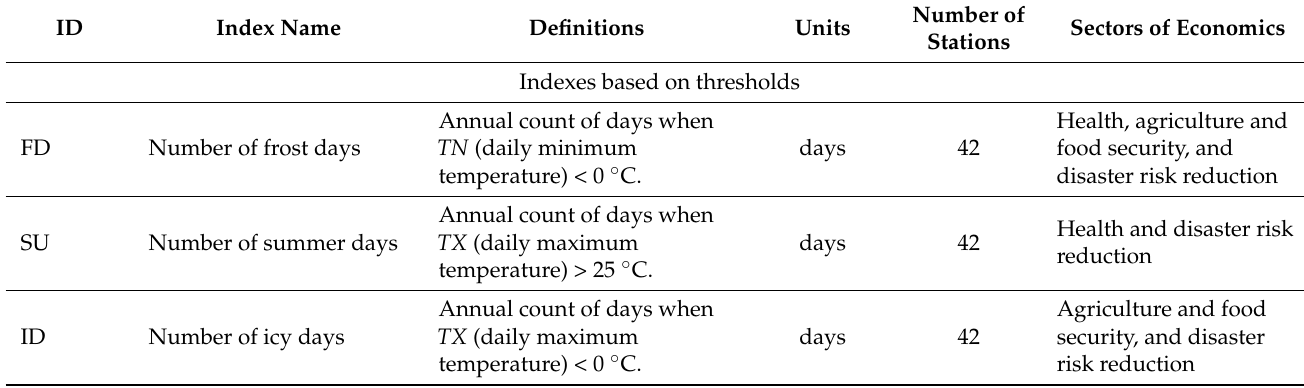
Table 2. Temperature and precipitation indexes with their definitions and units used in this